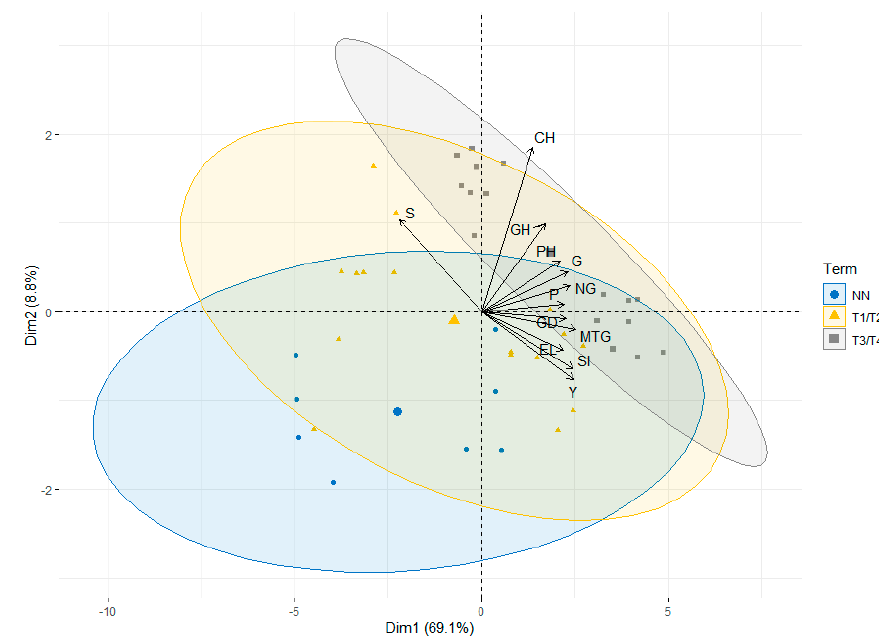
Figure 3. PCA biplot showing the interaction between terms of application (T1 / T2, T3 / T4) and selected traits in spring wheat with the distinction of acetylsalicylic acid concentrations. PH-plant height; EL-ear length; CH-chlorophyll; NG-number of grains per ear; MTG-mass of a thousand grains; Y-yield; P-proteins in grain; G-gluten in grain; S-starch in grain; SI-sedimentation index; GH-grain hardness index; GD-grain density.